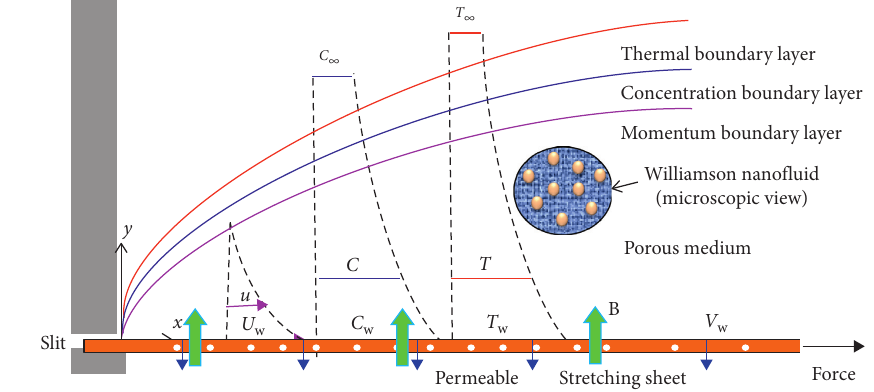
Figure 1: Physical configuration of the flow